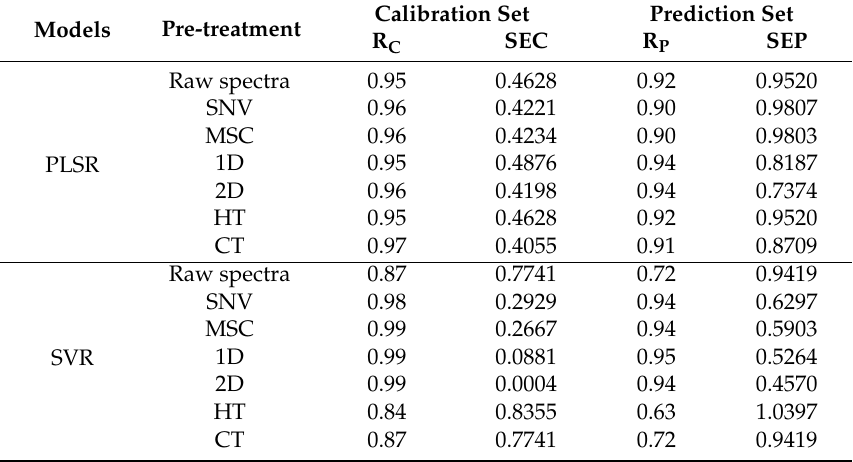
Table 2. Results of prediction models (partial least squares regression (PLSR) model and support vector machine regression (SVR) model) with different pre-treatments. SNV: standard normalize transformation; MSC: multiple scatter correction; 1D: first derivative; 2D: second derivative; HT: haar transformation; CT: centering transformation; SEC: standard error of calibration set; SEP: standard error of prediction